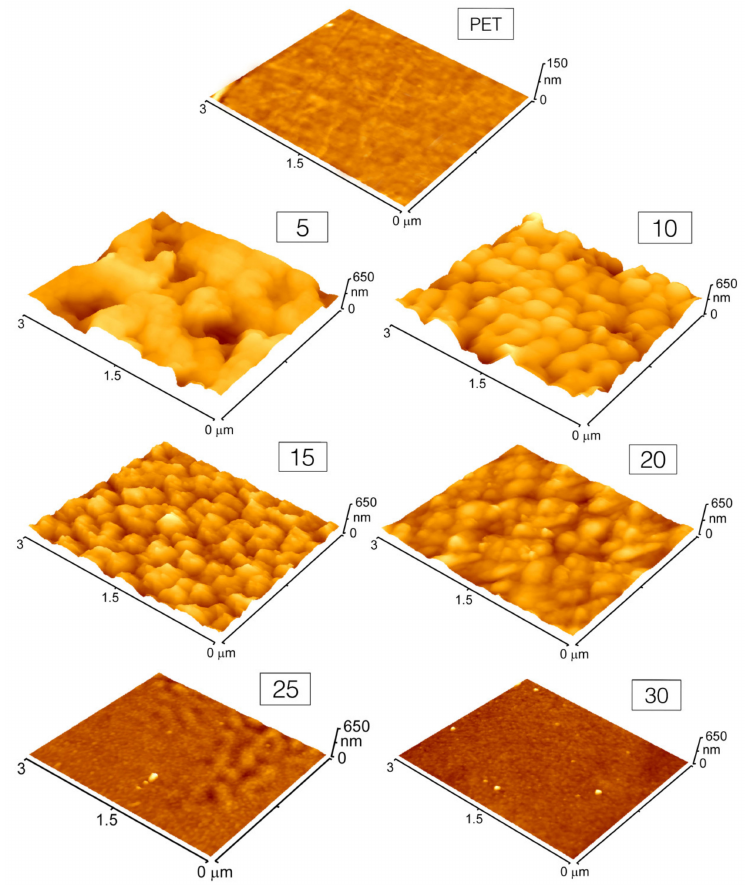
Figure 3. AFM images of PET after its irradiation in the presence of AgNPs colloids of different Ag concentrations. Numbers in the boxes indicate the concentration of silver in the immobilization solution. (Notice: Z-axis scaling in the case of pristine PET is limited to 150 nm due to naturally flat surface